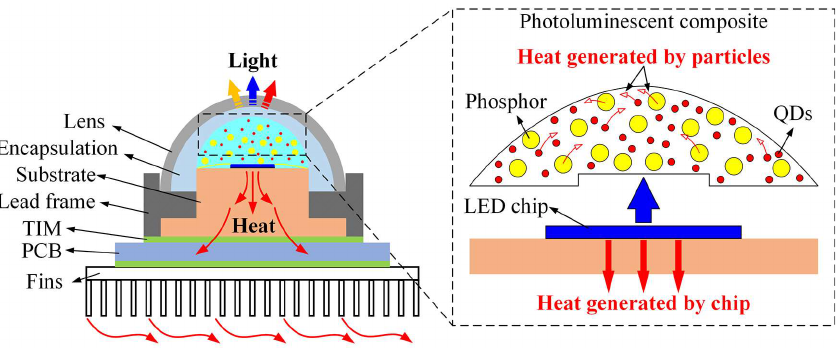
Figure 1. Schematic showing the packaging structure and heat generation mechanisms of WLEDs.